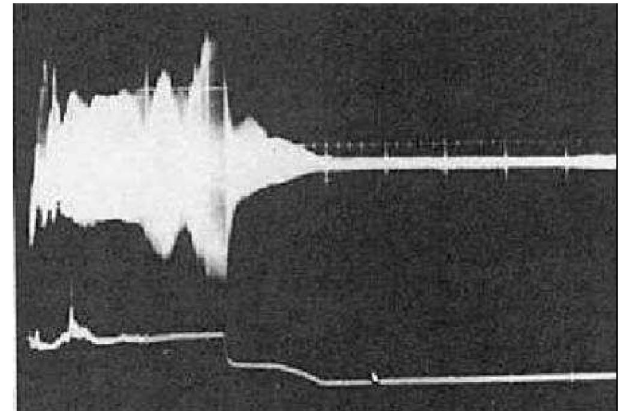
FIG. 2. Observation of coherent vertical instability at the Argonne ZGS in 1965 [18]; oscilloscope traces show the insta- bility; the sweep rate is 0 : 2 s = cm ; top trace: signal from a vertical pickup; bottom trace: beam current.